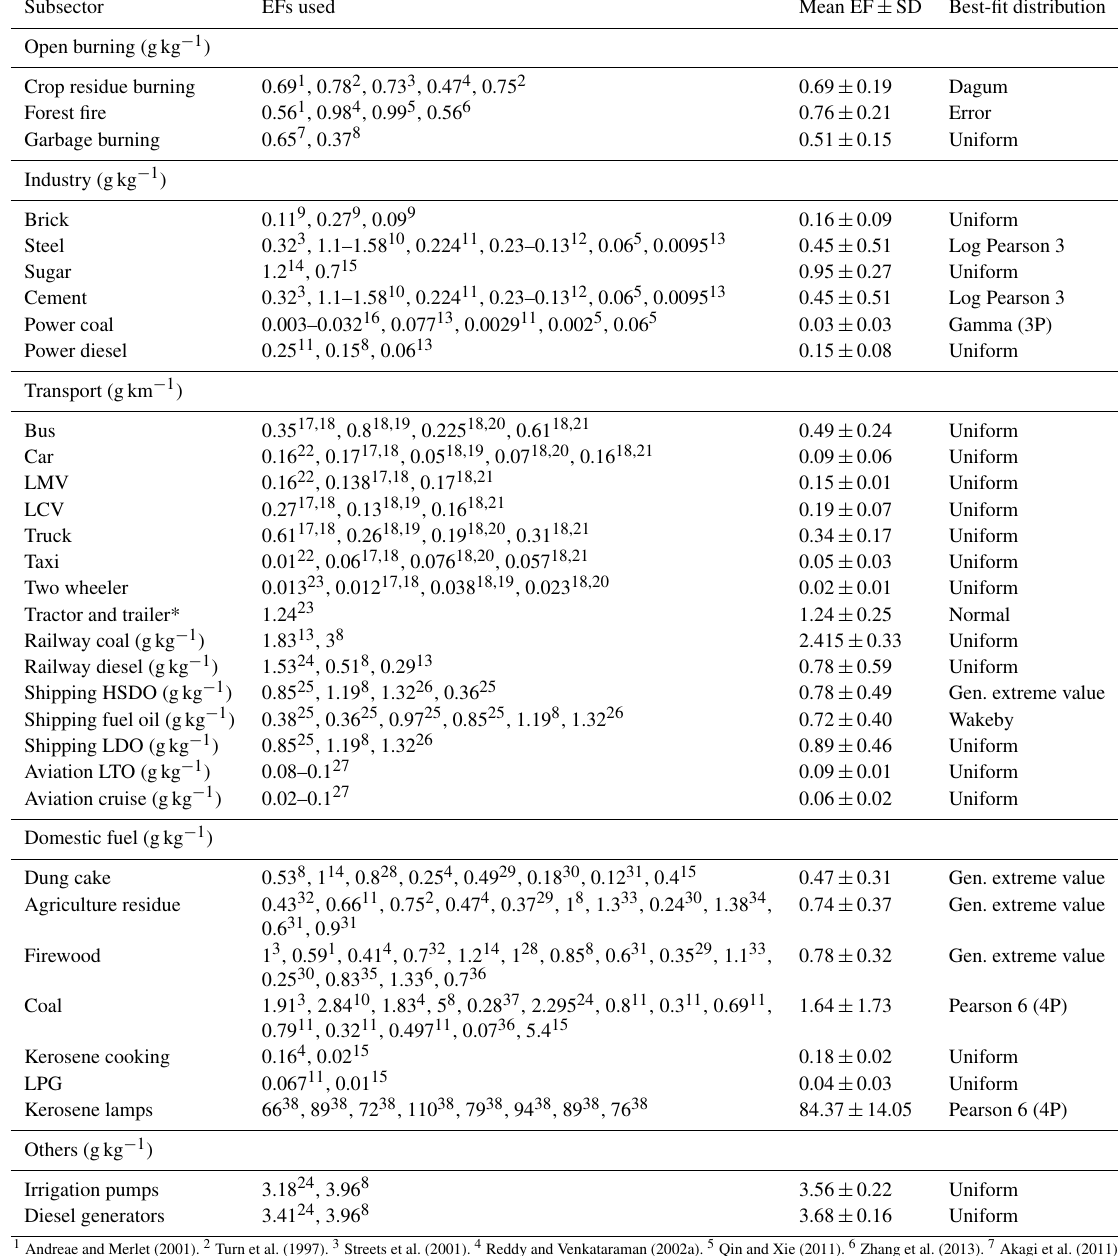
Table 2. Mean EFs, standard deviation and best-fit probabilistic